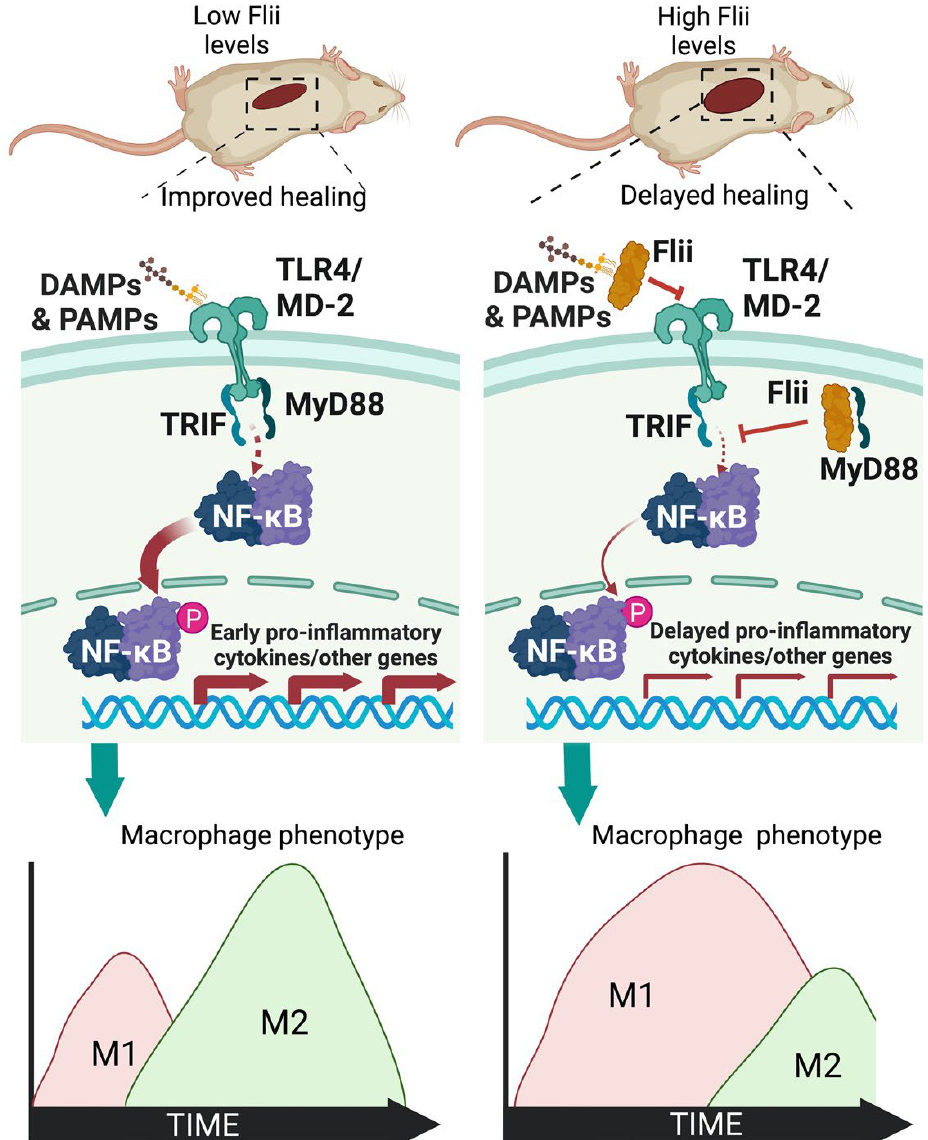
Figure 7. Schematic showing the effect of Flii on TLR4 signalling and wound macrophage phenotypes. As the levels of Flii increase, signalling through the TLR4-NF- κ B pathway is dampened, and there is a delay in the shift to M2 reparative macrophage phenotypes in the wound, which delays wound healing. (Created with BioRender.com, accessed on 6 July 2022.)